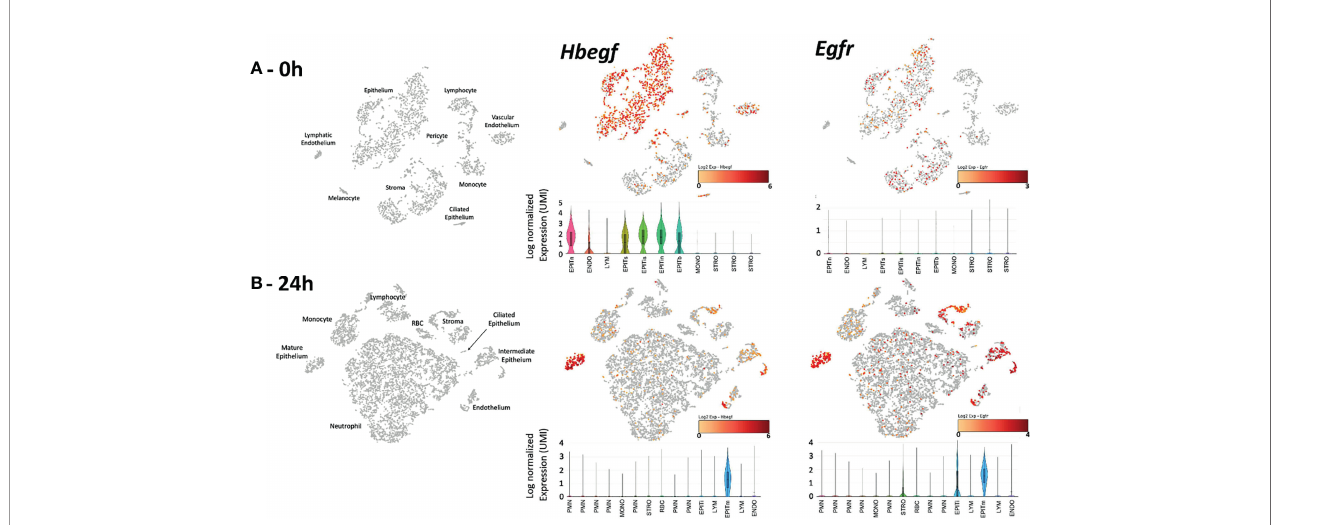
FIGURE 1 | Expression of Hbegf and Egfr genes in the different cell types of the normal (A-0h) and infected (B-24h) mouse ME. Clustering of ME cells (in gray) and their identi fi cation is displayed in PCA plots, with cells expressing of Hbegf and Egfr shown in a continuum from pale organ to red indicating relative expression level according to each scale. Violin plots provide quantitative analysis, with height showing relative intensity of expression and width indicating the number of cells (UMIs) at that expression level. (A-0h) Hbegf is expressed primarily by fi ve clusters of ME epithelial cells representing recognized ME subtypes including basal (EPITb), secretory (EPITs), intermediate secretory (EPITis), intermediate non-secretory (EPITin) and non-secretory including ciliated (EPITn) (Ryan et al., 2020), by vascular endothelial cells (ENDO) and by small subsets of other cells. Egfr is expressed by subsets of all epithelial and stromal (STRO) cell clusters. (B-24h) Twenty-four hours after NTHi infection, large numbers of in fi ltrating neutrophils (PMN) in six clusters, monocytes (MONO) and lymphocytes (LYM) dominate the ME, with structural cell types in smaller proportions and epithelial cells in only two clusters: mature (EPITm) and intermediate (EPITi). The different PMN subtypes re fl ect the increasingly recognized and as yet poorly understood diversity of neutrophils (e.g. Hesselink et al., 2019). As in the normal ME, Hbegf is expressed primarily by epithelial and vascular endothelial cells. Normalized gene expression by epithelial cells was higher than in that in the uninfected ME (mean of 2.42 log 2 UMIs versus 1.58 log 2 ). Egfr mRNA is present in most epithelial and stromal cells, but also in vascular endothelial cells. Epithelial cell (0.86 log 2 UMIs) and stromal cell (0.50 log 2 ) expression was higher than that in the uninfected ME (0.11 log 2 for both) In PCA plot cells, the color orange indicates detectable expression of the